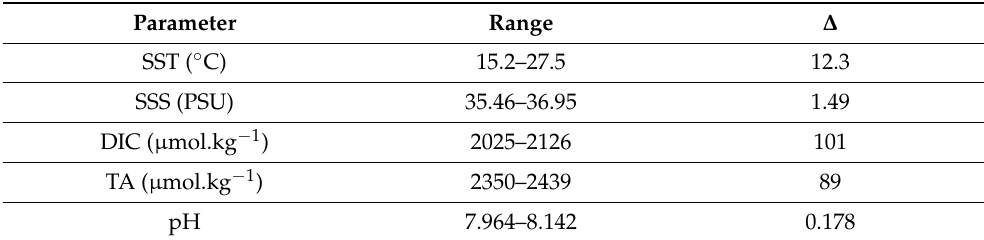
Table 1. Data value range and difference ∆ along the transects M/V Equinox (ID: MLCE NCEI Accession 0154382) for the entire cruise